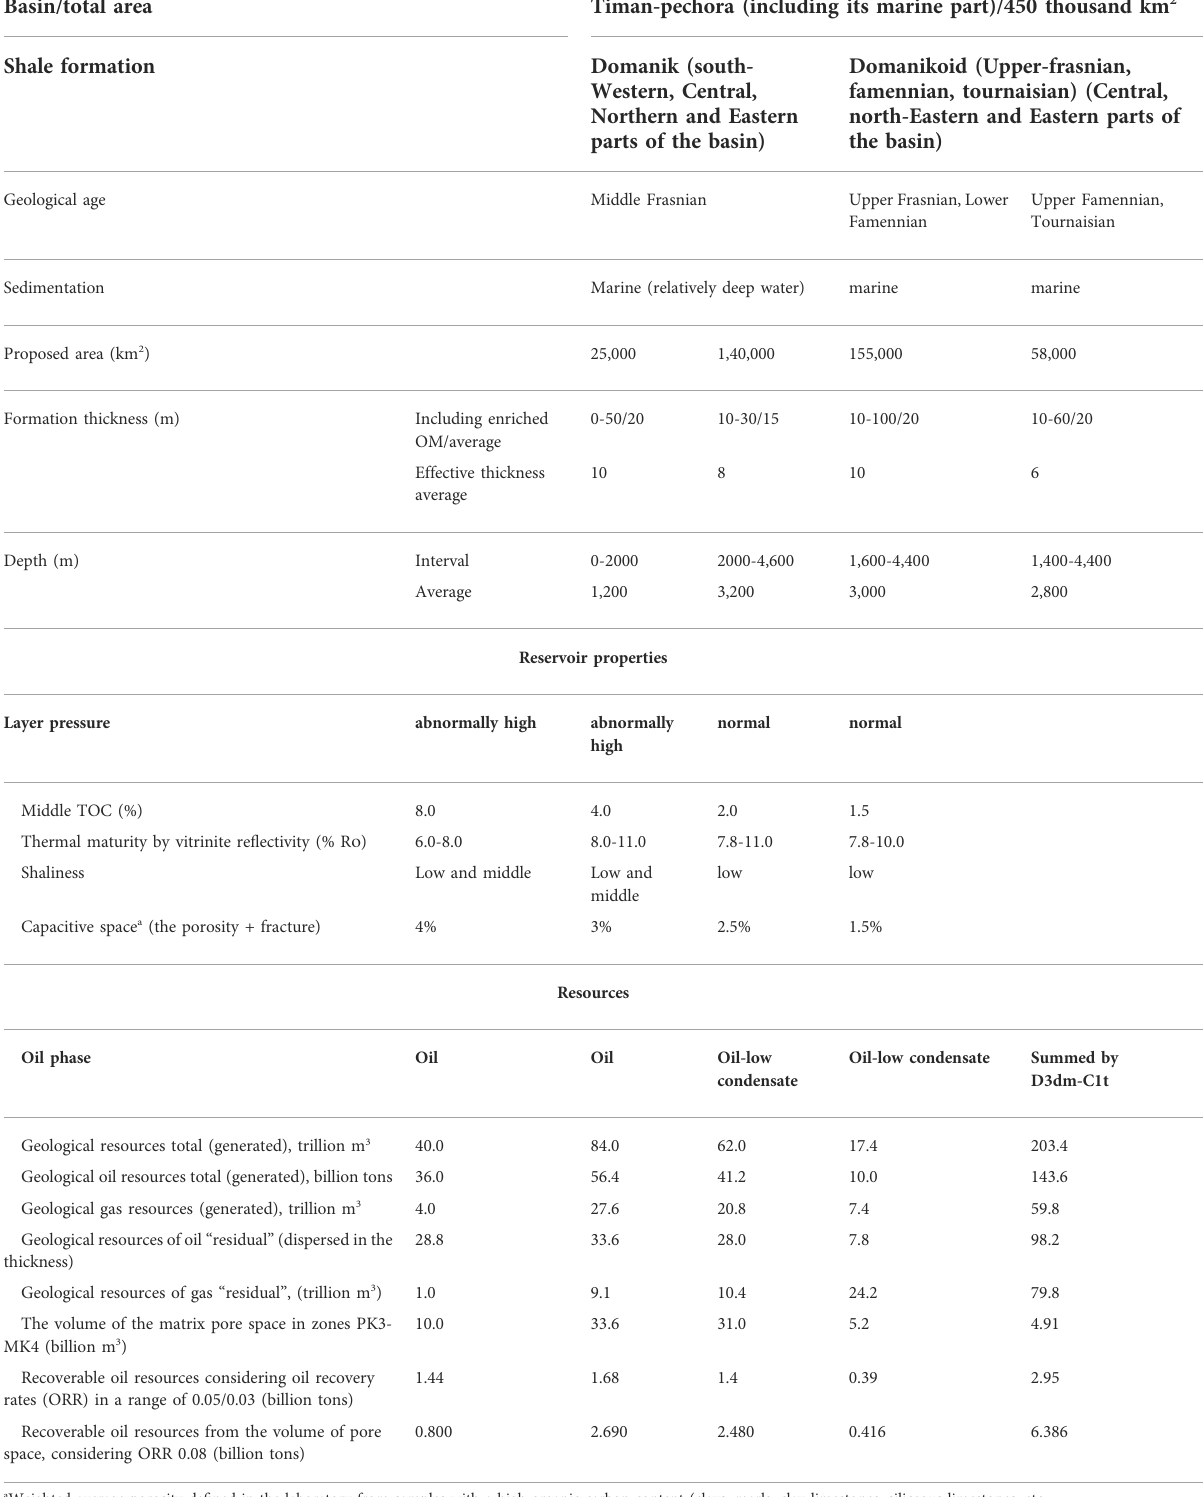
TABLE 7 Characteristics of the Domanik formation of the Timan-Pechora OGP and assessment of unconventional accumulations of hydrocarbons in the Domanik shale strata [according to the authors study using the balance equations (Neruchev et al.,